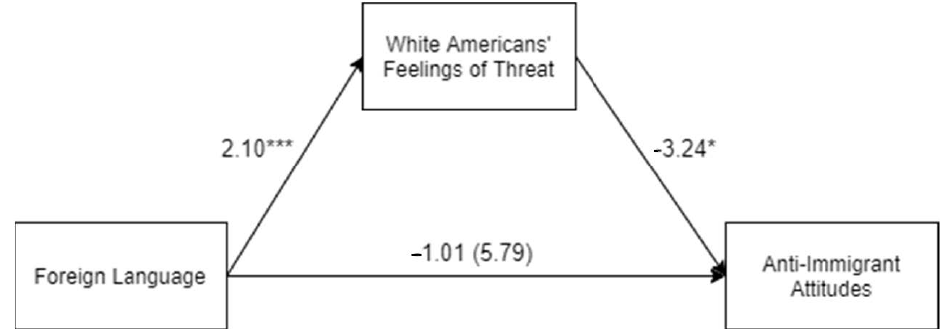
Figure 1. Mediation model for the relation between exposure to foreign language and anti-immigrant attitudes (Study 1). Note : Statistics for each path are unstandardized estimates. The unstandardized estimate in parentheses is the direct effect of foreign language on anti-immigrant attitudes, controlling for White Americans’ feelings of threat. * p < 0.05. *** p < 0.001.